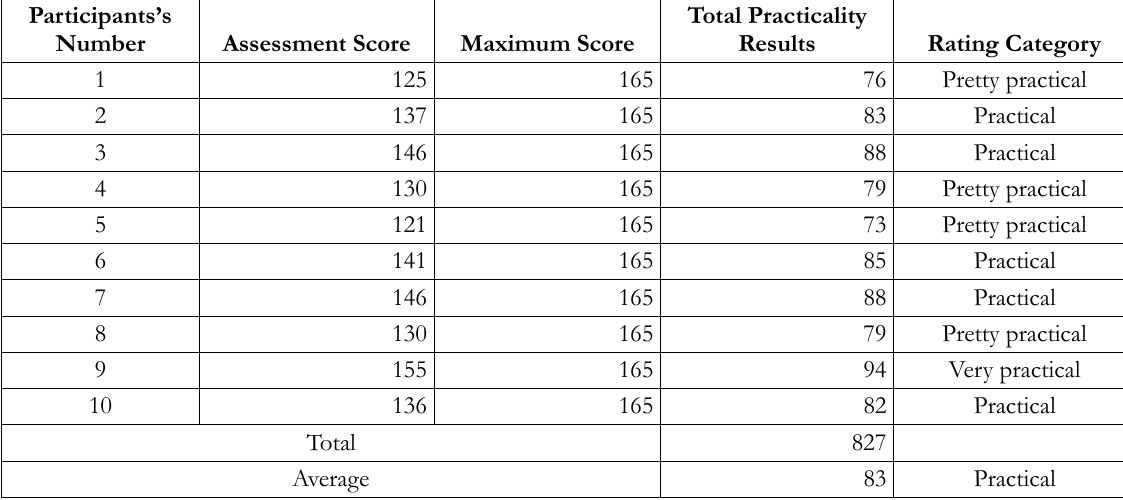
Table 5. Summary of practicality results for the development of network-based online learning